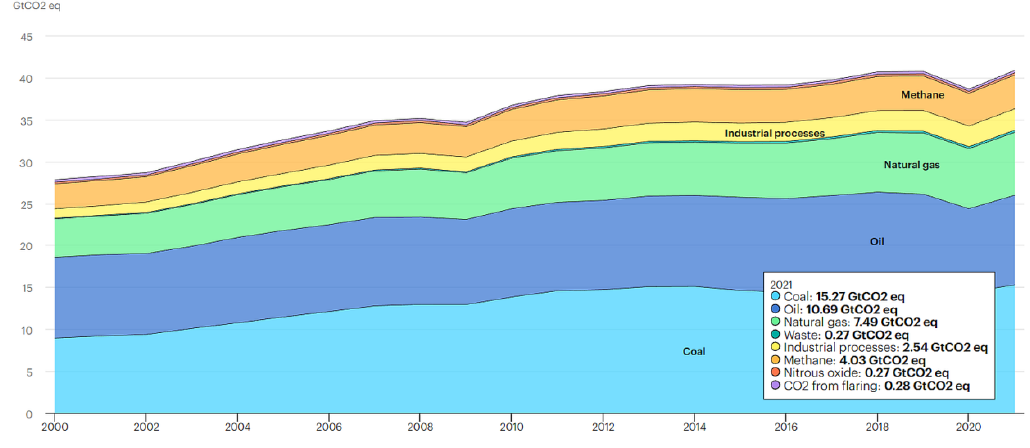
Figure 1. Energy related GHG emissions by source worldwide